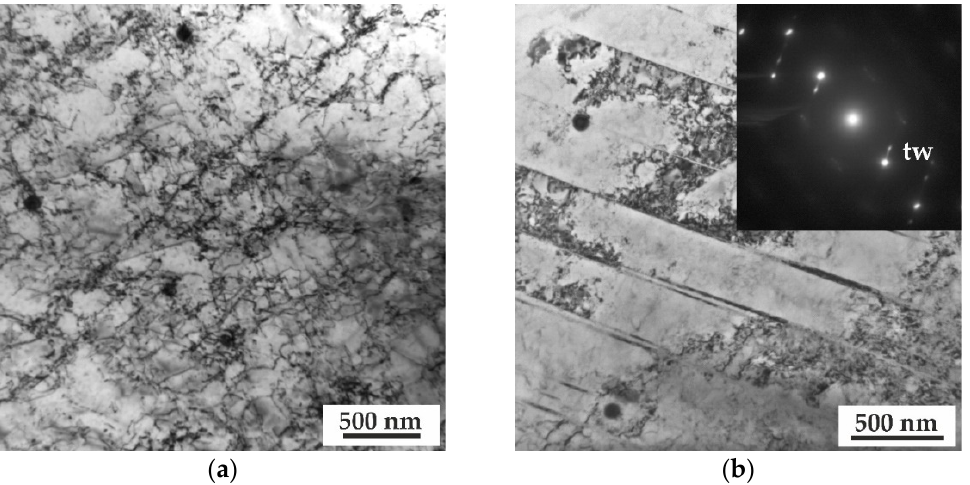
Figure 5. TEM Bright Field (BF) images after ST. Dislocation substructure and dispersed particles ( a ), microtwins with corresponding selected area electron diffraction (SAED) pattern and dispersed particles, zone axis close to [110] matrix + [ − 1 − 10] twin ( b ).